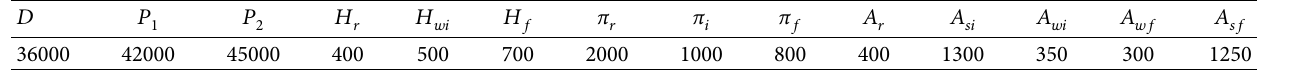
Table 2: The input parameters of a three-level supply chain.